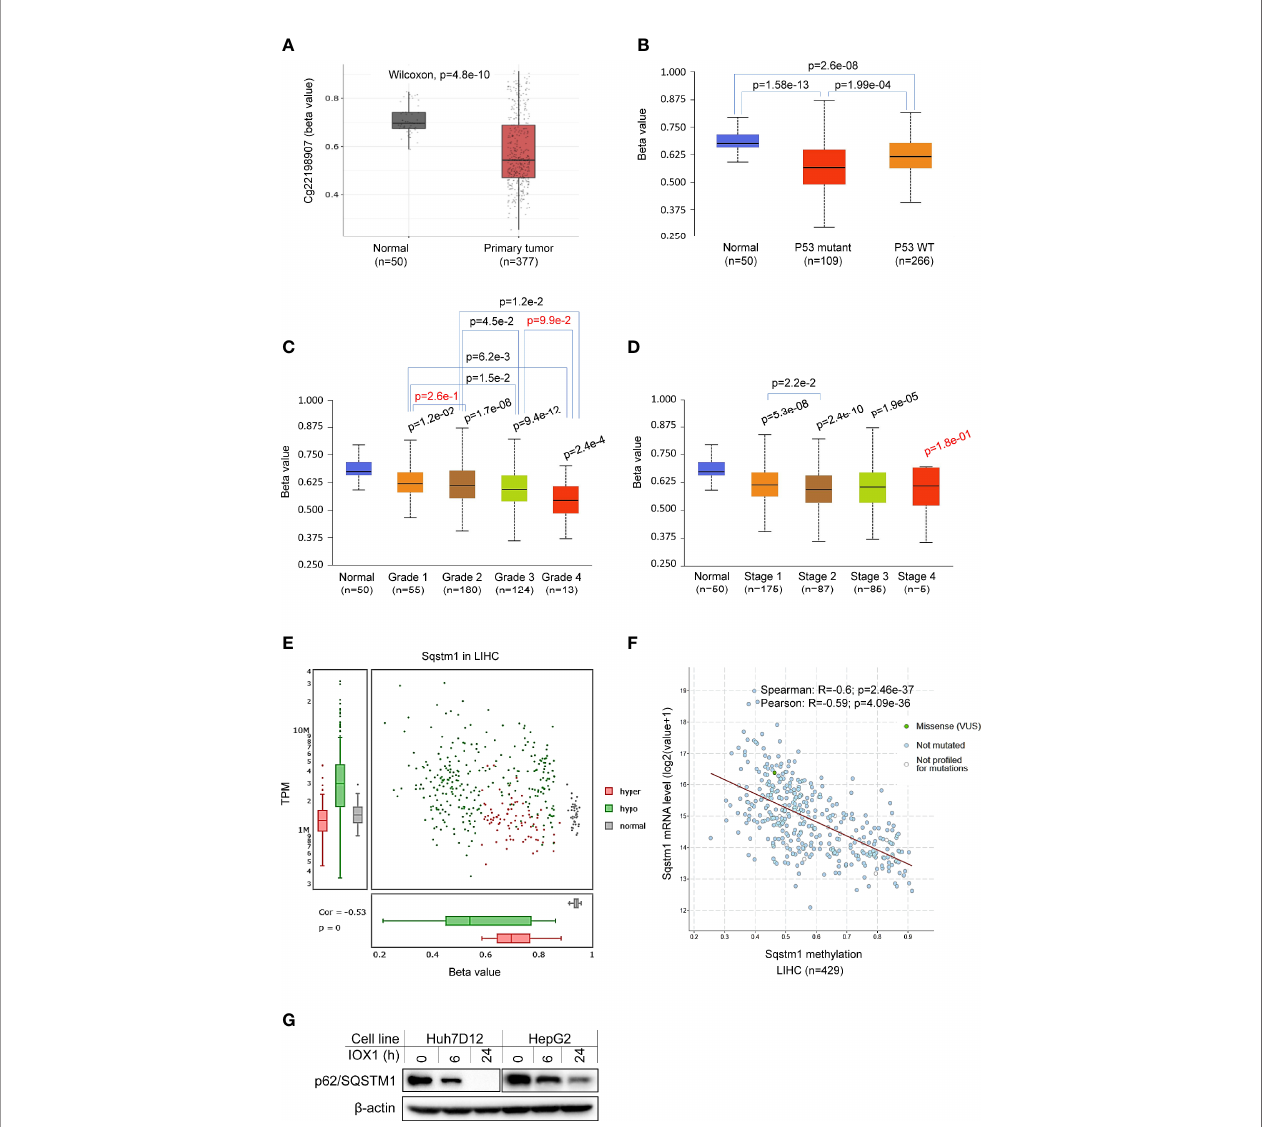
FIGURE 6 | Association of Sqstm1 expression level with its promoter methylation. (A) The Sqstm1 gene promoter is signi fi cantly demethylated in LIHC. (B) p53 is association with Sqstm1 gene promoter demethylation. (C) The Sqstm1 gene promoter is signi fi cantly demethylated in all stages. (D) The Sqstm1 gene promoter is gradually demethylated through the cancer progress. (E) Analysis of hyper- and hypo-methylation of the Sqstm1 gene promoter. (F) The Sqstm1 promoter methylation is reversely correlated with its expression. p values in red are not signi fi cant. (A) is the results from SAMRT portal, (B – D) from UALCAN, E from DriverDBv3, and F from cBioportal. (G) Experimental validation of demethylation in regulation of SQSTM1 expression. Huh7D12 and HepG2 cells were treated with 0.3 mM of the demethylase inhibitor IOX1 for indicated hours, followed by